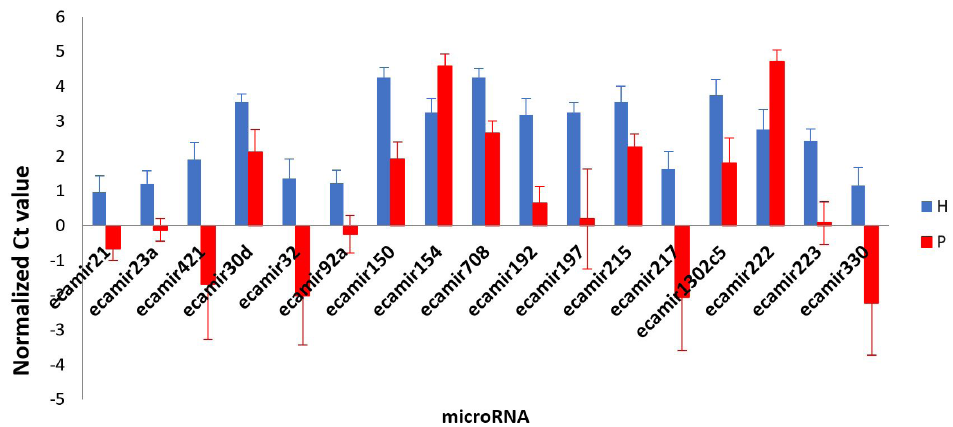
Figure 5. Delta Ct values of significantly different miRNAs between groups: combined horses versus (H) combined ponies (P).